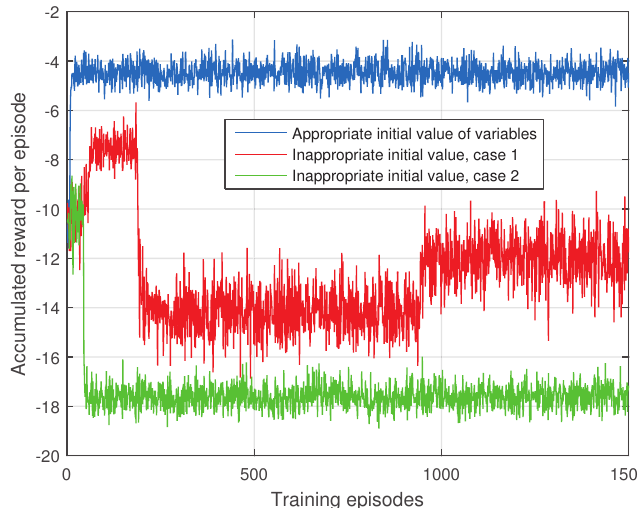
Figure 2. The impacts of the initial value of θθθ and w on the accumulated reward.